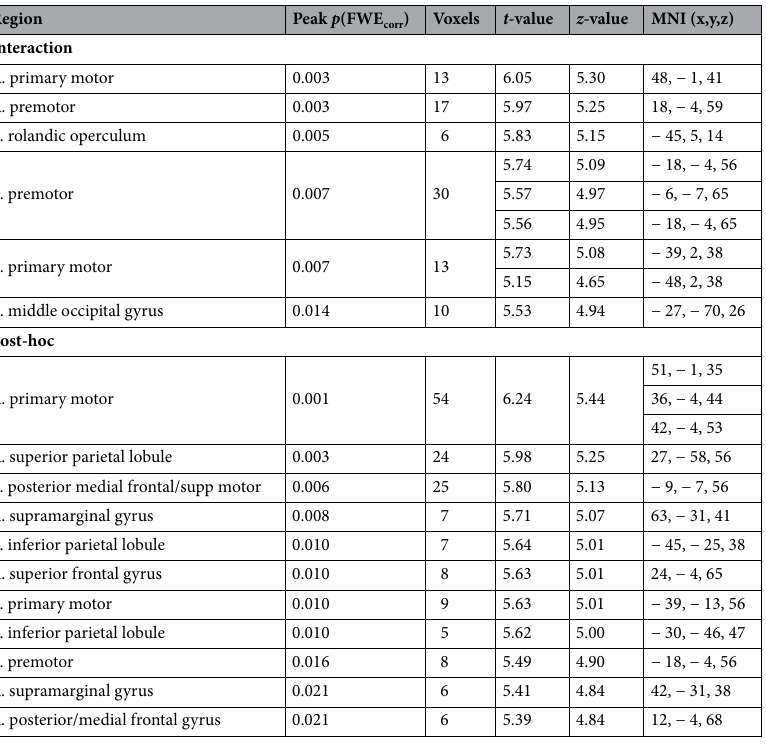
Table 2. 2 × 2 analyses comparing group changes in the PPI Learning contrast over time show a significant decrease in connectivity from the thalamus seed region to the bilateral primary and premotor regions in response to escitalopram ( Interaction ). Post-hoc analyses reveal significant decreases in PPI connectivity between baseline and steady state within the thalamus seed region of the escitalopram group ( Post - hoc ). Results shown at a p < 0.05 Family-Wise Error corrected (FWE corr ) on the whole brain voxel level. Significant results with < 5 voxel extent not shown. L left, R right, peak MNI Montréal Neurological Institute